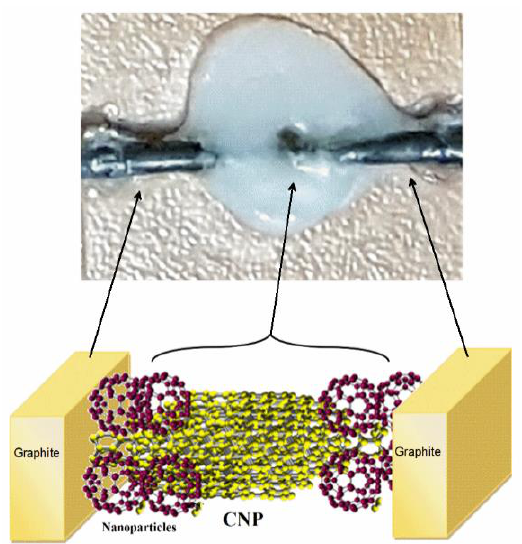
Figure 2. The real device ( top ), and its schematic representation ( bottom ).